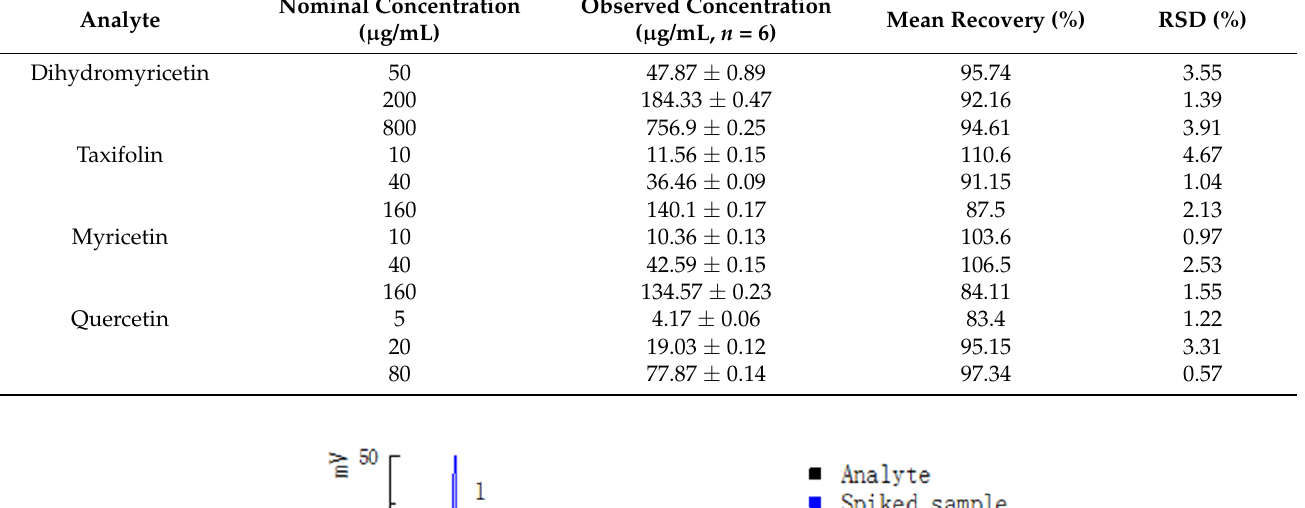
Figure 2. Chromatographic profiles of standard mixture. 1: Dihydromyricetin; 2: Taxifolin; 3: Myri- cetin; 4: Quercetin.